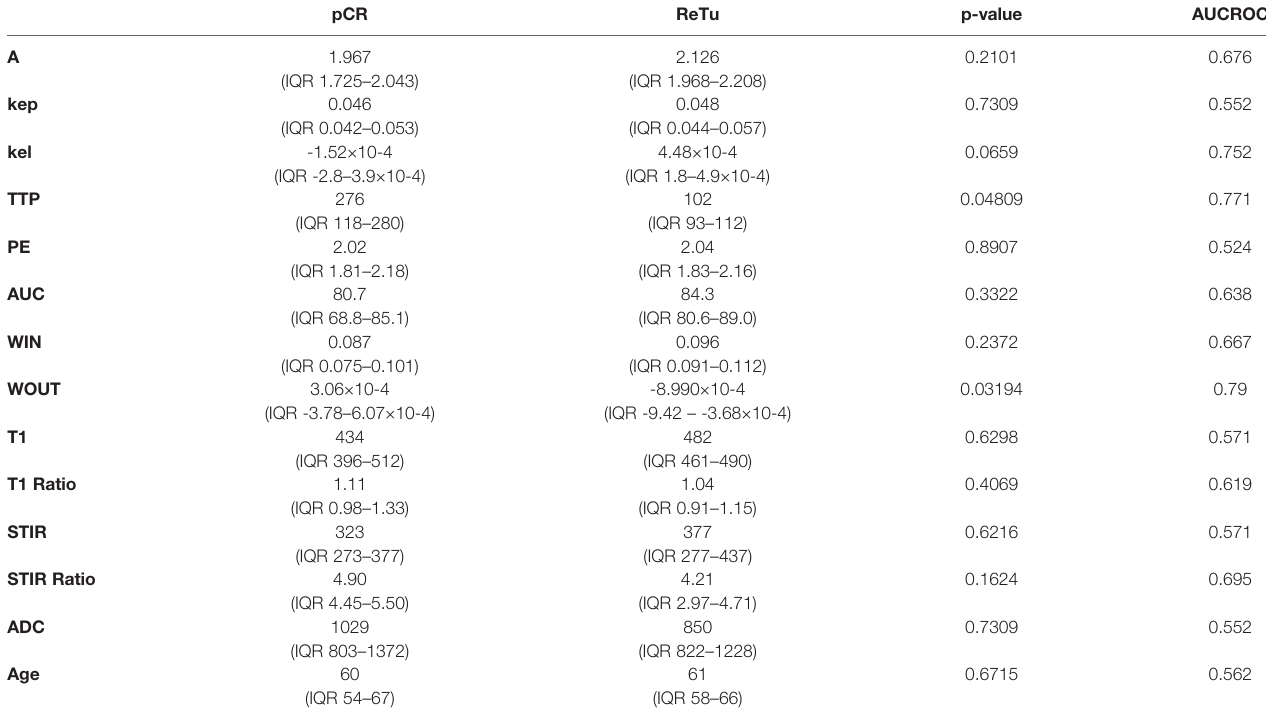
TABLE 2 | Median and interquartile ranges (IQR) for DCE parameters at baseline, conventional MRI imaging features, ADC values in whole tumor volume and age with respective p-values using Wilcoxon signed rank-test and area under the curve of the Receiver Operating Characteristic (AUCROC). pCR ReTu